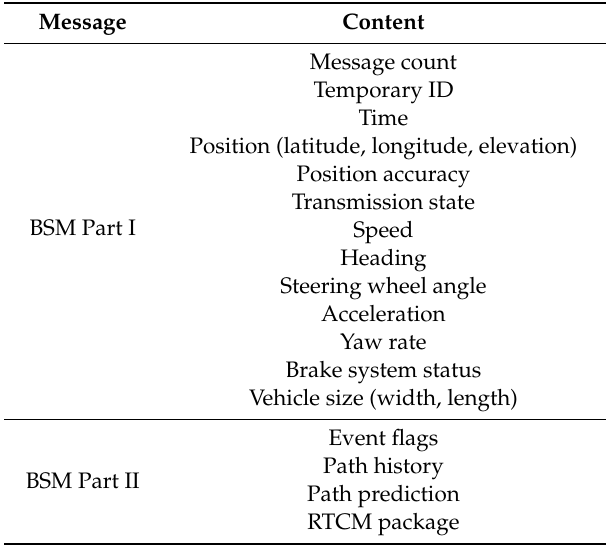
Table 5. Basic safety message (BSM) format.